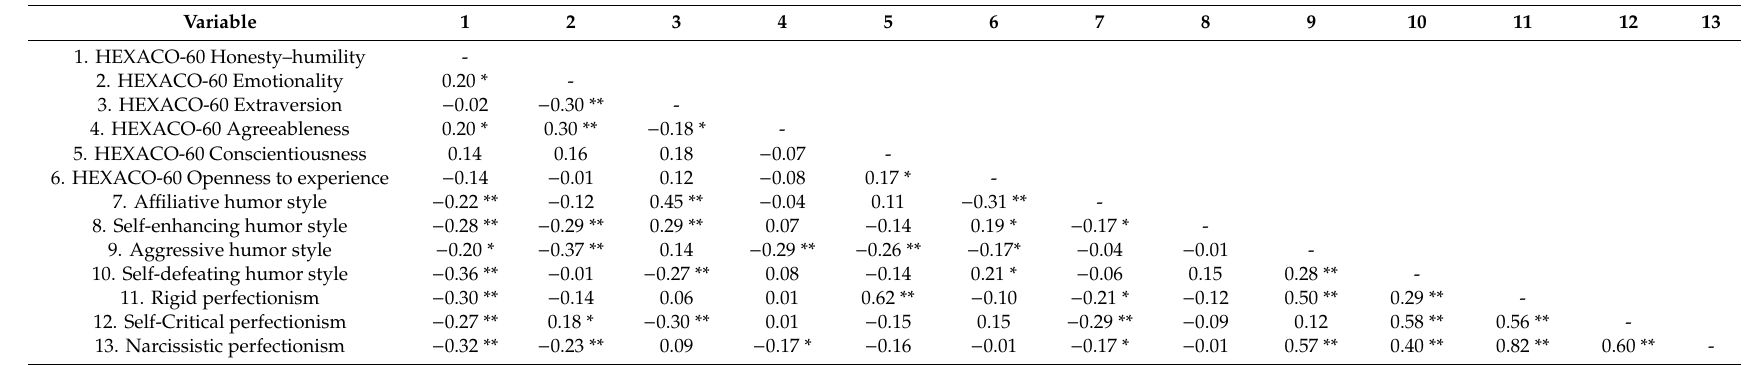
Table 1. Standard deviations, and correlations between HEXACO-60, Humor Styles Questionnaire (HSQ), and Big Three Perfectionism Scale (BTPS).